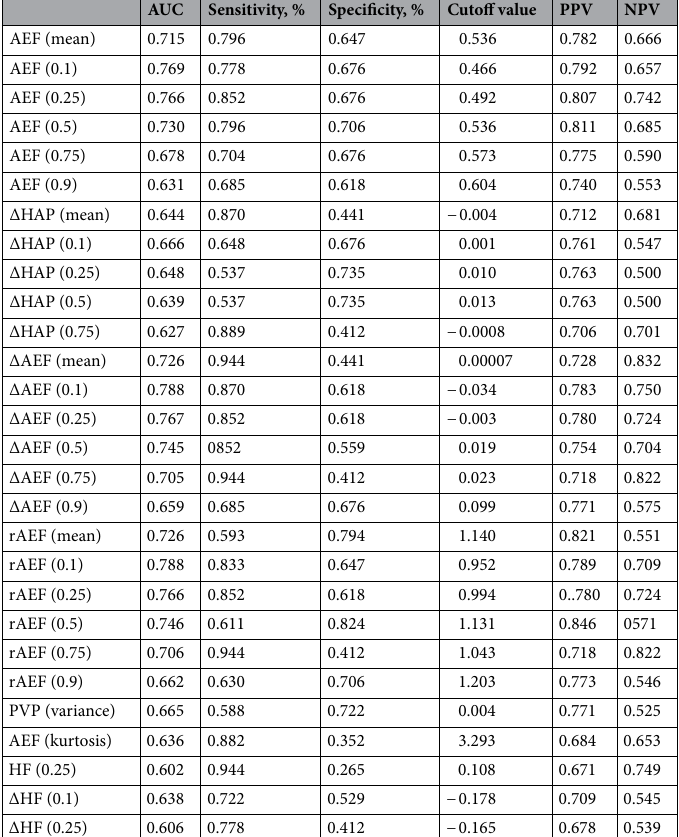
Table 4. ROC analysis of statistically significant parameters for the differentiation between HCCs and IMCCs. AUC Area under the curve, ROC Receiver operating characteristic, PPV Positive predictive value, NPV Negative predictive